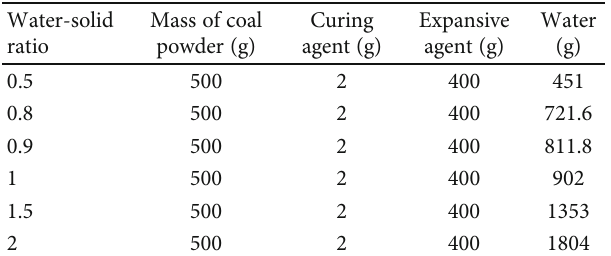
Table 1: Proportioning scheme of water-solid ratio.